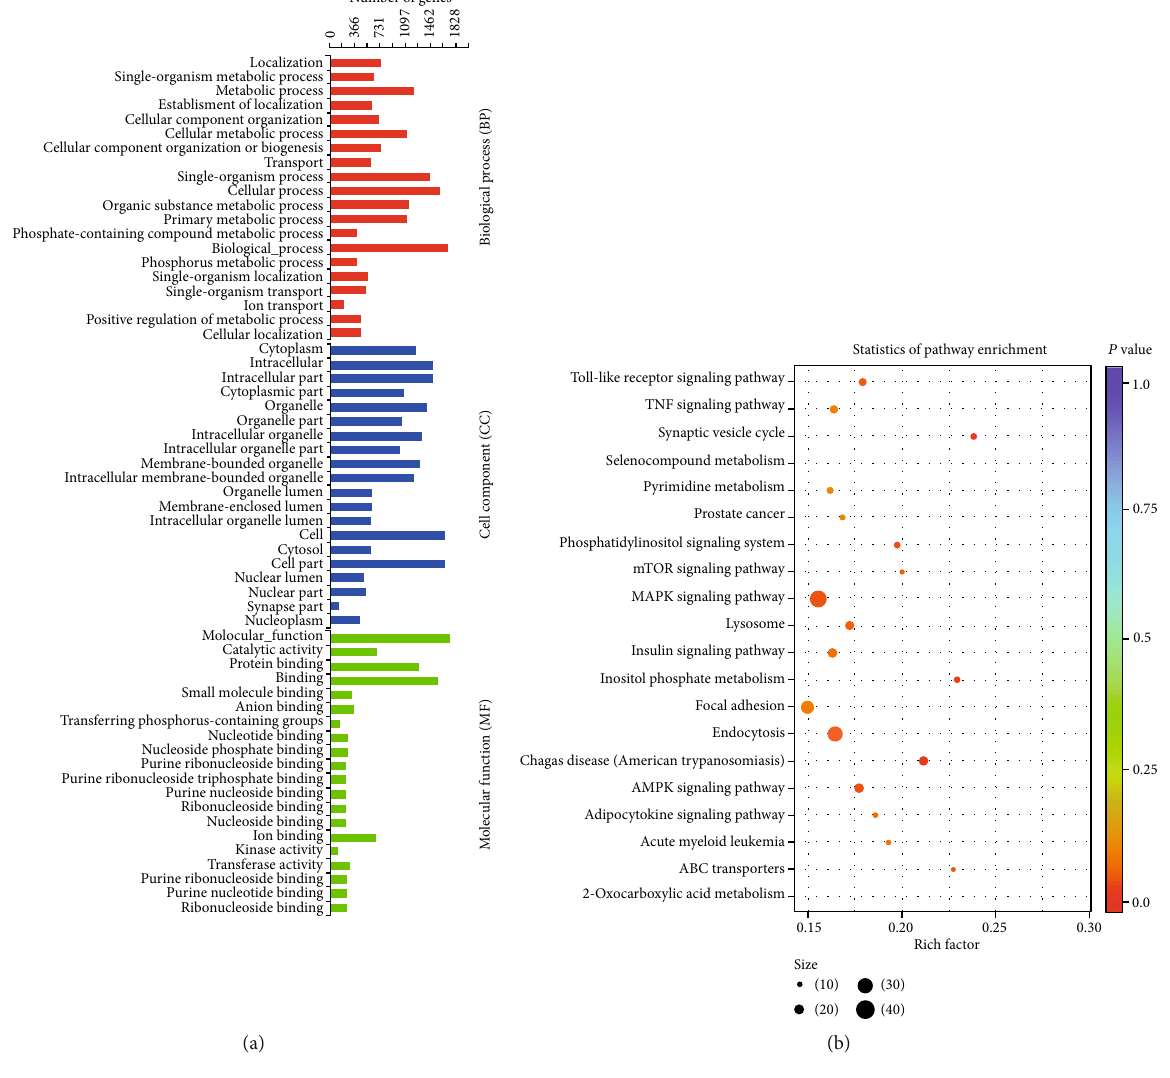
Figure 7: GO analyses and KEGG pathway analysis: (a) enrichment map of GO analyses — biological process, cellular component, and molecular function; (b) enrichment map of KEGG pathway